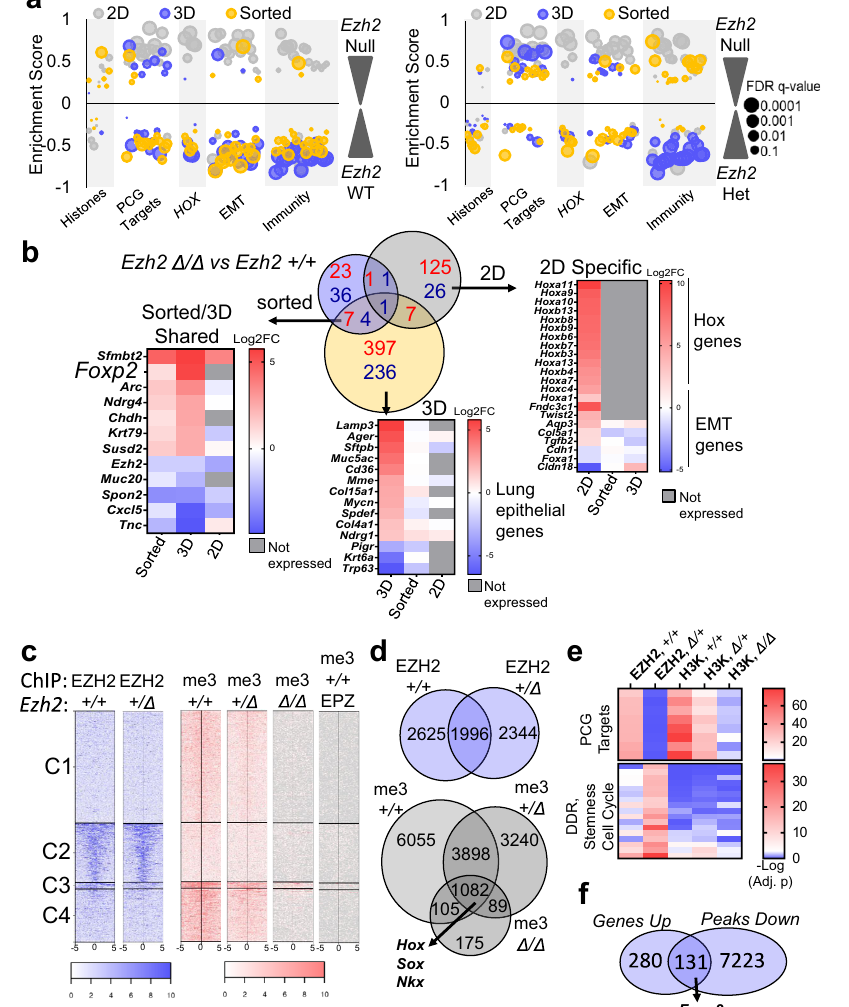
Fig. 3 | Ezh2 de fi ciency leads to diverse gene expression in different models. a Rank-ordered gene lists were queried against the MSigDB databases and enrichment scores of selected gene signatures enriched in the Ezh2 null or Ezh2 heterozygous compared to Ezh2 WT for the indicated models were plotted. Dots size estimates FDR. Data are summarized in Supplementary Table 4. b Venn dia- gramandheatmapsdepictsigni fi cantdifferentiallyexpressedgenesin Ezh2 nullvs. WT cells for the indicated culture systems, with log-fold change LFC>0.5 or LFC< − 0.5,FDR<0.05.Geneshigherin Ezh2 nullareinred,geneslowerin Ezh2 null are in blue. Heatmaps depict LFC of selected genes identi fi ed by the indicated contrasts. c Heatmap representation of EZH2 and H3K27me3-bound chromatin peaks centered across a ±5-kb window that showed decreased occupancy of Ezh2